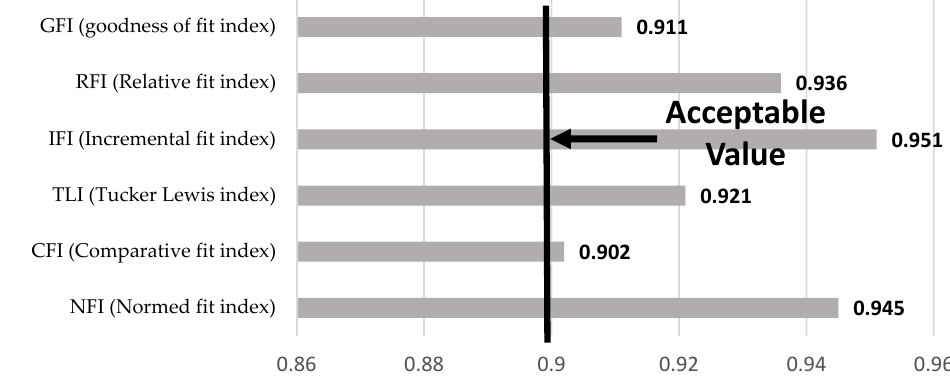
Figure 3. Model fit analysis.